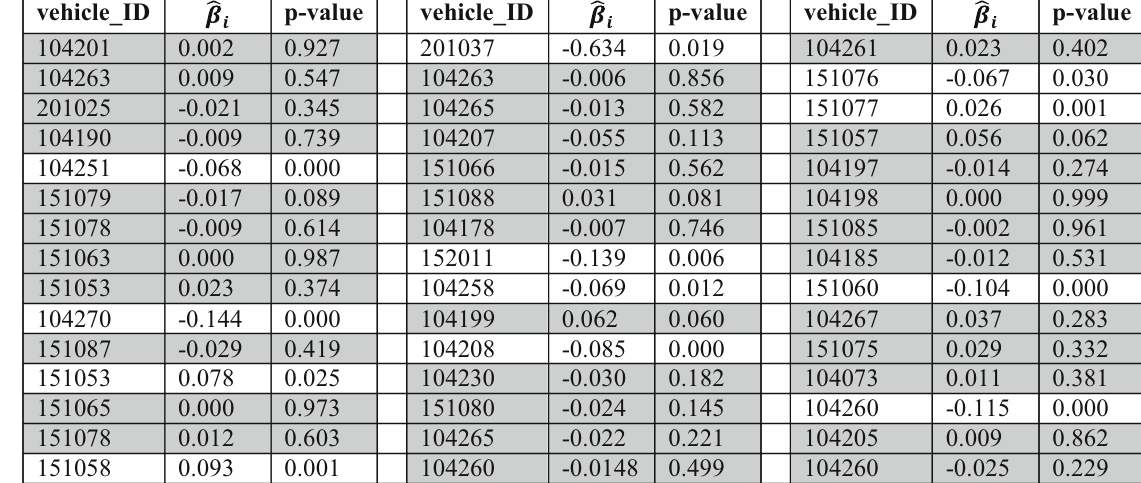
Estimated coefficients and p-values for the first 45 freight vehicles. P -value > 0.05 are underlined with shaded